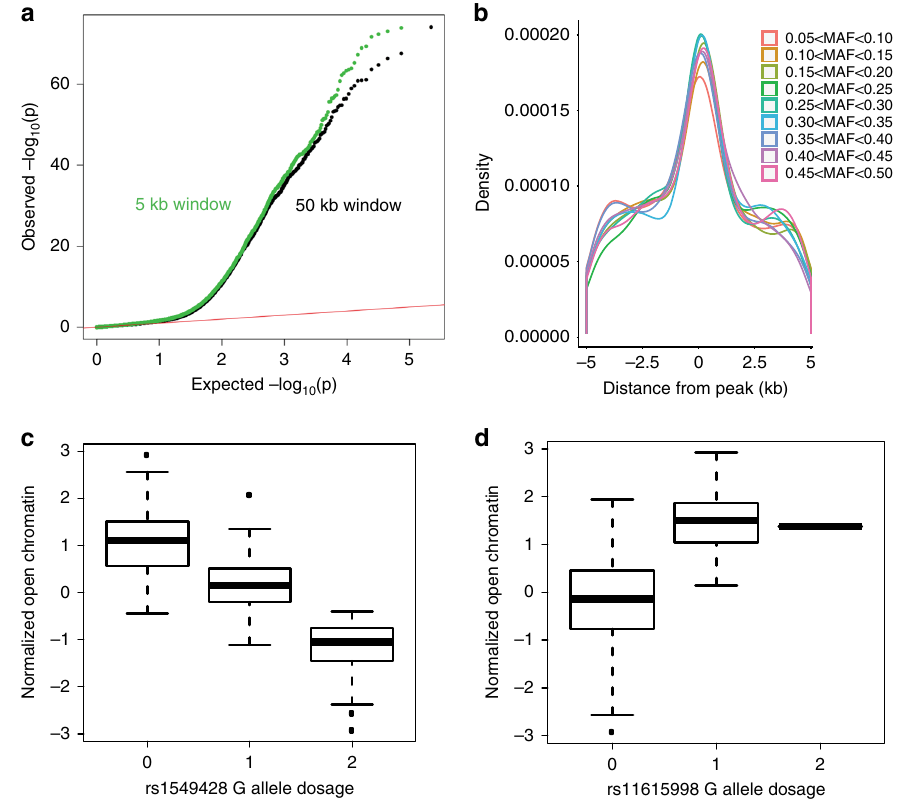
Fig. 4 Identi fi cation of chromatin QTLs (cQTLs). a QQ plot of cQTLs using window size of 5 kb (green) or 50 kb (black). Both show marked deviations from the expected. b Distance of cQTLs relative to the center of ATAC-seq peaks as a function of minor allele frequency. c Most signi fi cant cQTL,